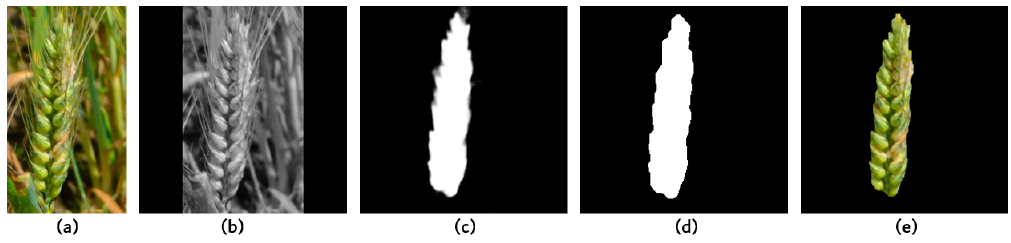
Figure 6. Segmentation results of the single wheat ear segmentation model. ( a ) Original image, ( b ) test image, ( c ) segmentation result, ( d ) binary image, ( e ) pseudo color image.